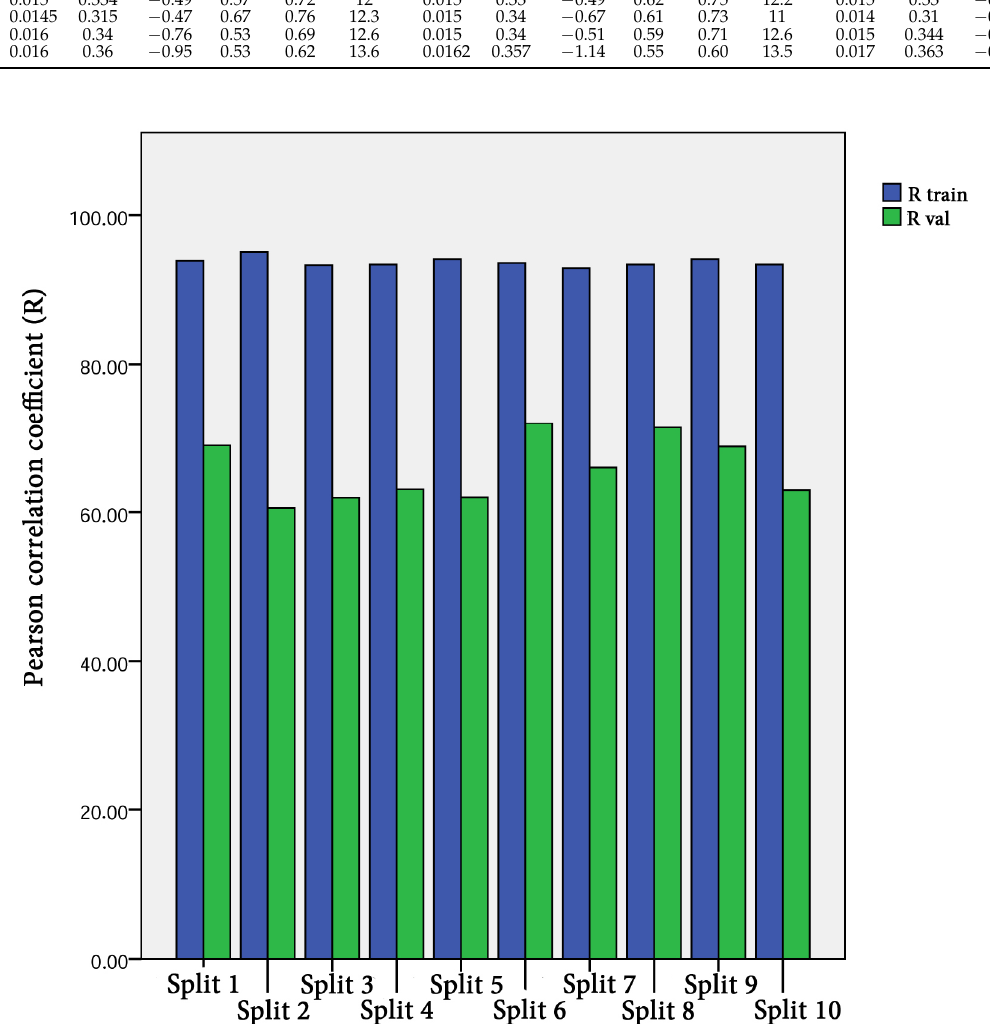
Figure 6. Performance measures of FS-RF models using K-fold cross validation with K = 10.